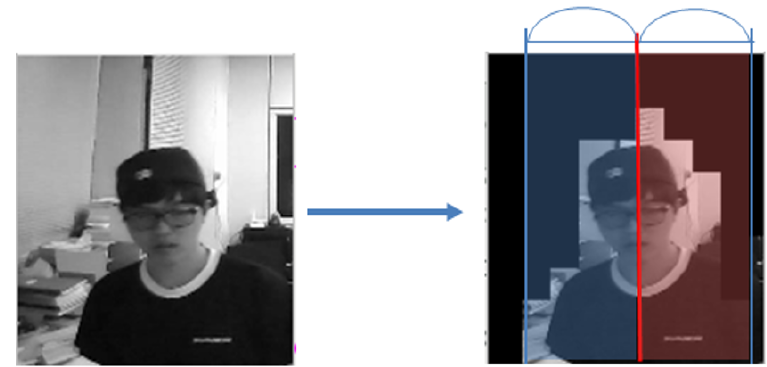
Figure 5. Detection verification through symmetric